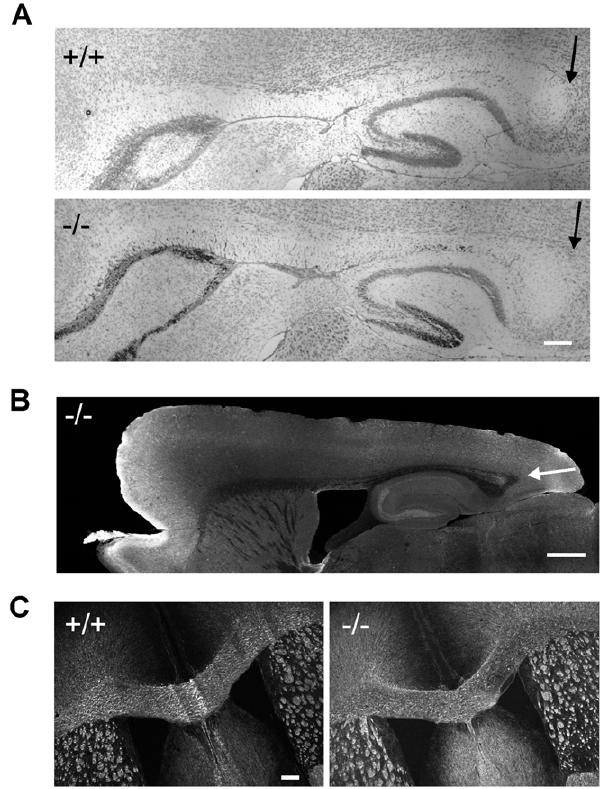
Figure 5. Absence of hypoplasia of posterior corpus callosum in b -III spectrin knockout mice. Sagittal sections from 8-week old WT ( + / + ) and knockout ( 2 / 2 ) animals stained with cresyl violet (A, Bar 200 m m) and anti-tau antibody (B, Bar 500 m m) with arrow pointing to posterior corpus callosum. C. Coronal sections immunostained for MBP (Bar 200 m m).